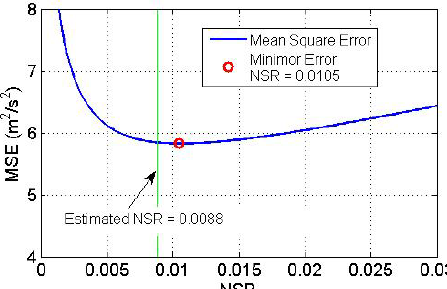
Figure 5 - Mean Square Error between shifted flowfield and corrected flowfield vs. NSR (blue). The red circle indicates the minimum-error NSR, and the green line indicates the estimated NSR.